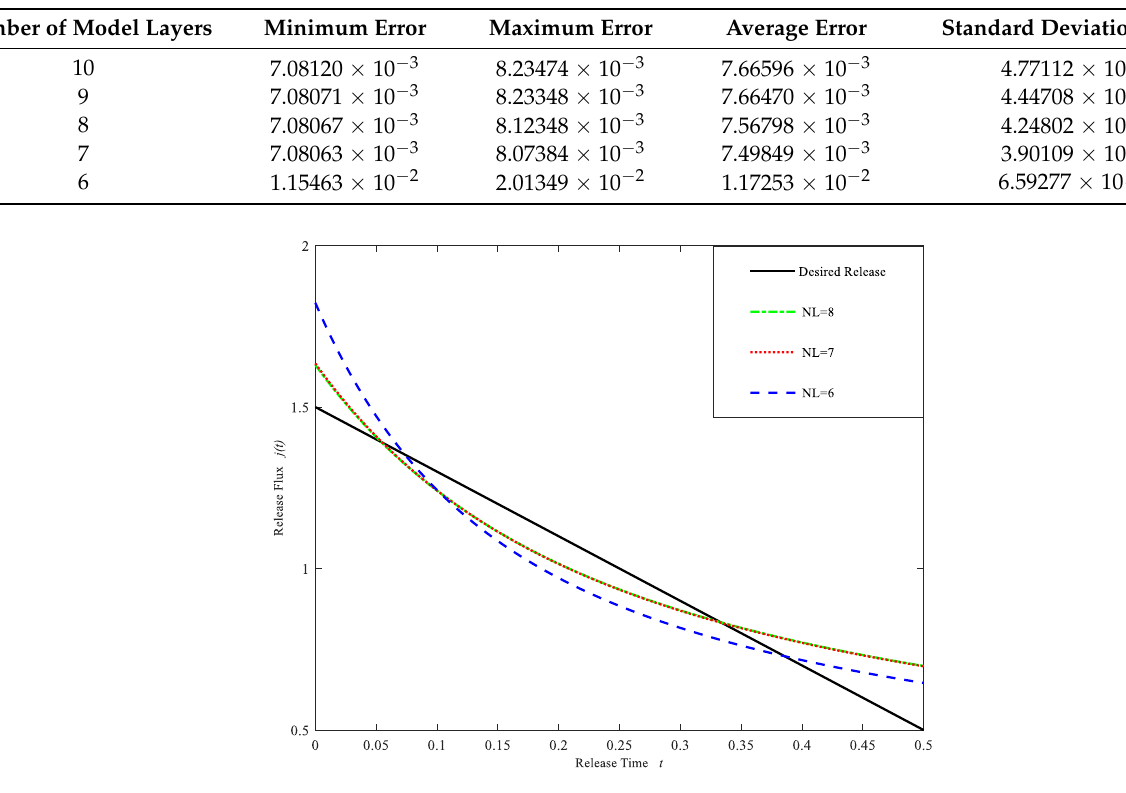
Figure 8. Drug Release profile for different layers NL = 6, 7, 8. (Case 2). Table 10. The initial drug concentration and diffusion coefficient at each layer of the controlled drug release model for NL = 7 (Case